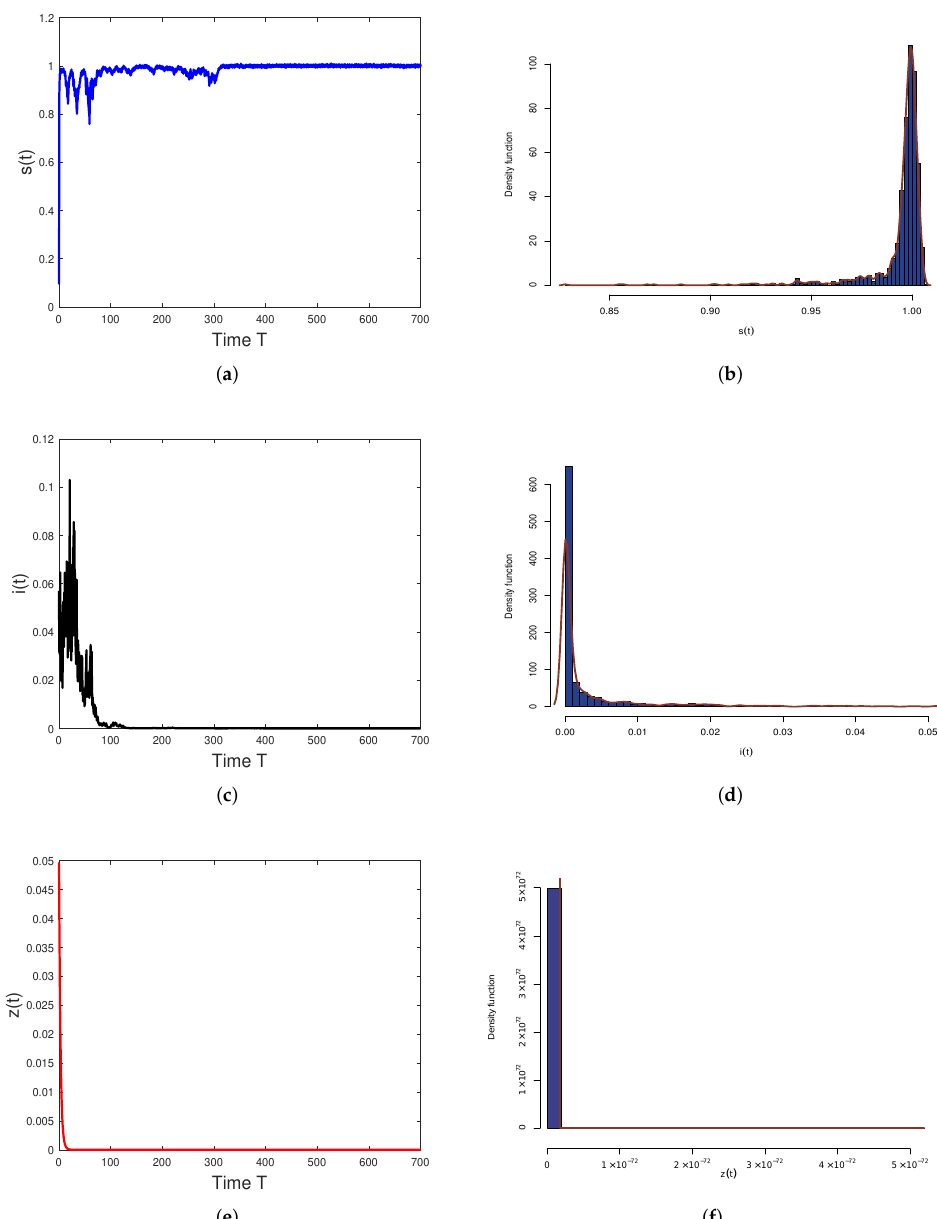
Figure 3. Susceptible phytoplankton s ( t ) is persistent; in the meanwhile, phytoplankton i ( t ) and zooplankton z ( t ) would be extinct with probability one, when the condition a − σ 2 − n < 0 are not satisfied in the second assertion of Theorem 2. Parameter − σ 2 2 < 0 and l 1 − b 2 − σ 1 1 2 2 values are chosen as n = 0.001, b 2 = 0.95, σ 1 = 0.01, σ 2 = 0.31, and σ 3 = 0.01, but the rest of the parameters are taken from Table 1. The initial value is ( 0.08,0.06,0.05 ) . ( a – f ) denote the evolution of a single path and the probability density curve (based on the 1000 simulations) of s ( t ) , i ( t ) , and z ( t ) ,